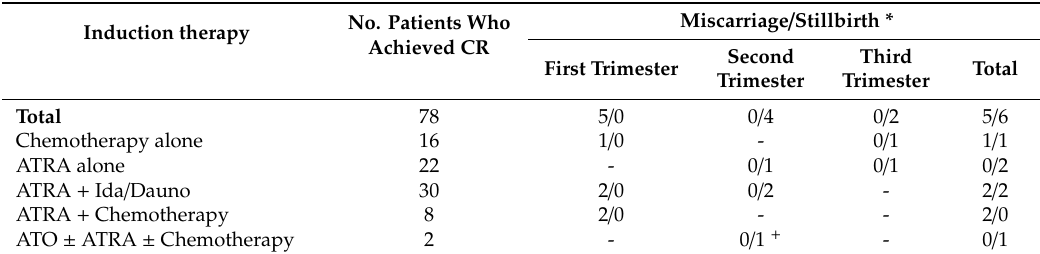
Table 6. Relationship between induction therapy and miscarriage / stillbirth by gestational age at